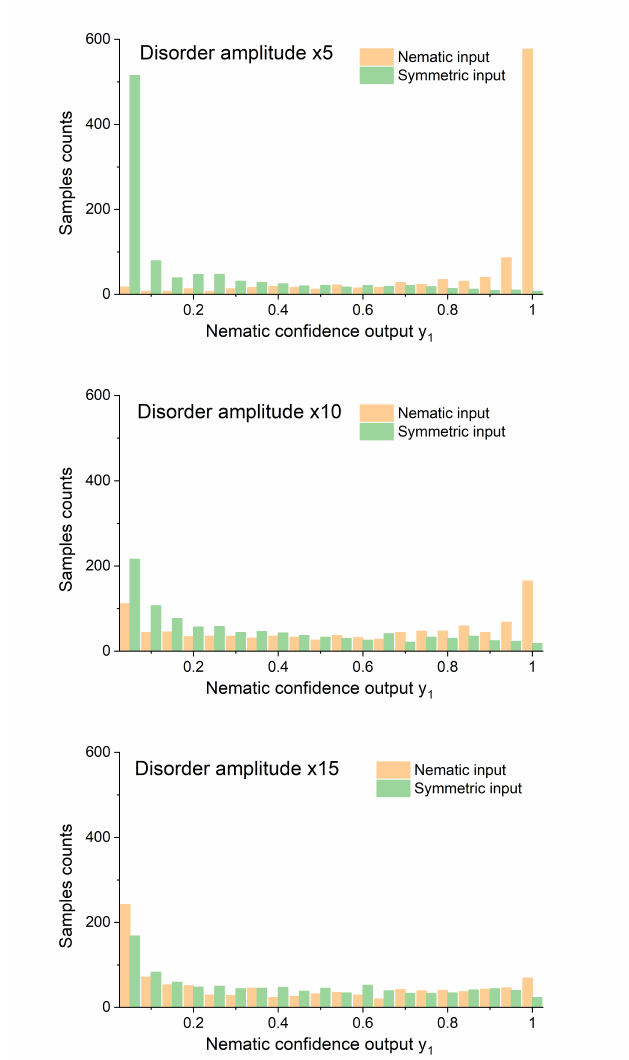
Figure 11: The accuracy of the ANN output decreases as the system approaches the strong disorder limit. The setting is similar to the lower panel in Fig. 2, yet with an impurity density around the upper limit and a much stronger δ t tudes. The ANN accuracy is no better than a coin flip 50% in the last